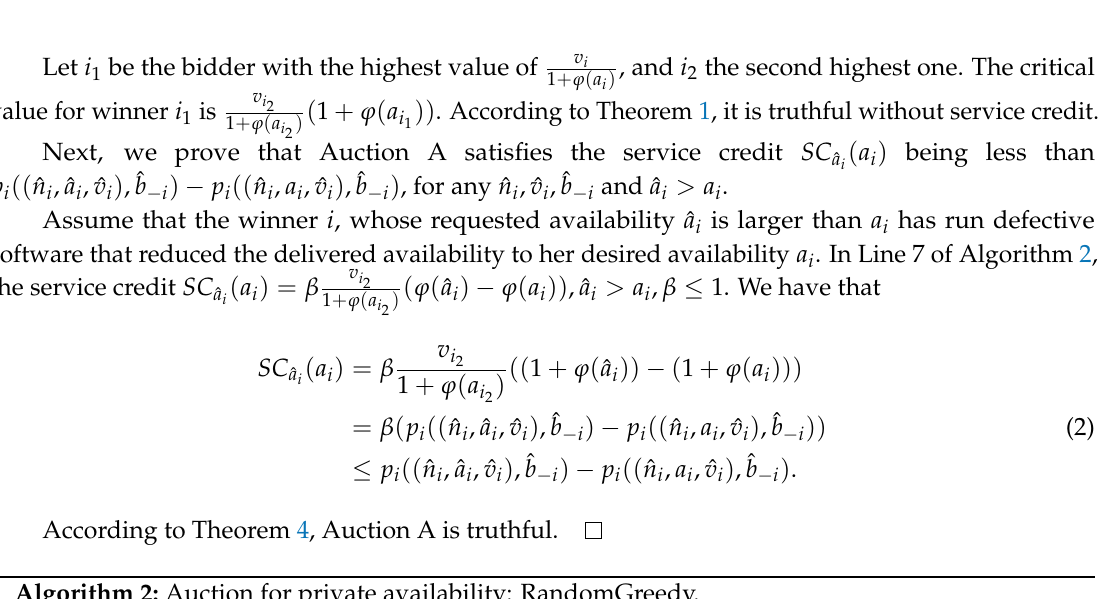
Algorithm 2: Auction for private availability: